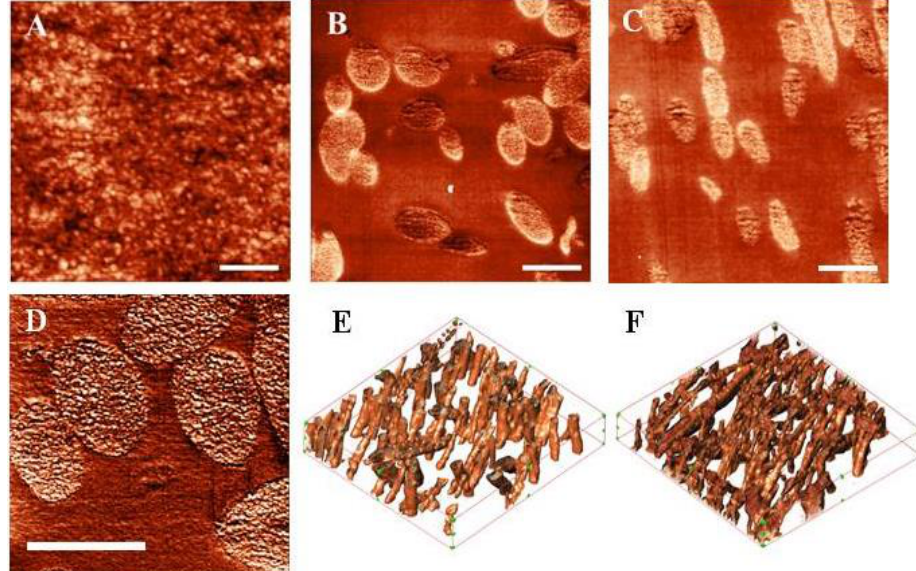
Figure 2. Film structure: ( A1 ) surface image; ( A2 ) surface profile along the specified line; and ( A3 ) three-dimensional image of the surface.